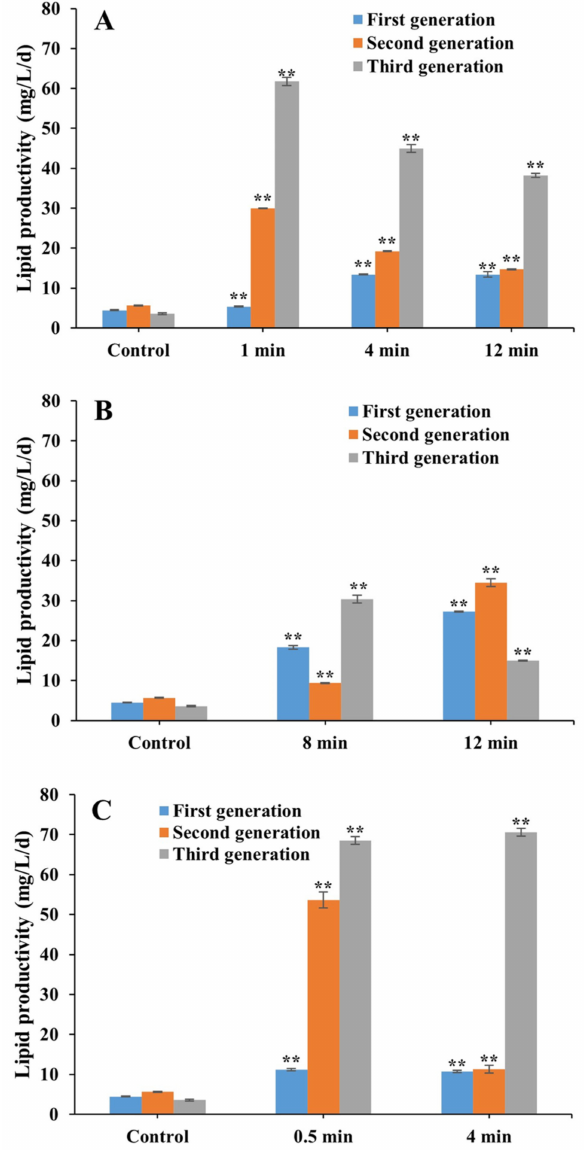
Figure 8. Lipid productivity of laser mutants of Chlorella vulgaris strain FACHB 9 treated with He–Ne ( A ), Nd:YAG ( B ), and SC ( C ) cultured under heterotrophic cultivation for 21 days (three generations). Data are presented as mean ± standard errors ( n = 3). Symbol “**” indicates statistically significant differences compared to controls at p <